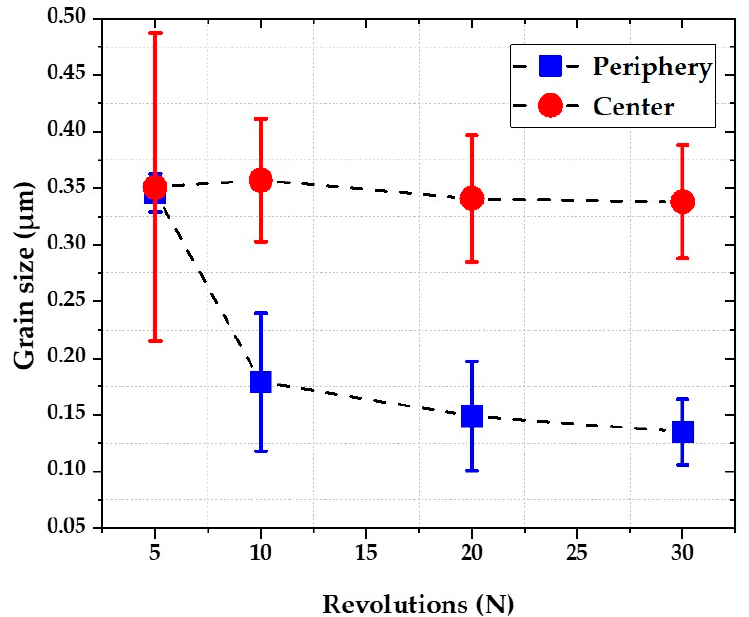
Figure 7. Evolution of the grain size as a function of the number of revolutions N in disks processed under 5 GPa of pressure.